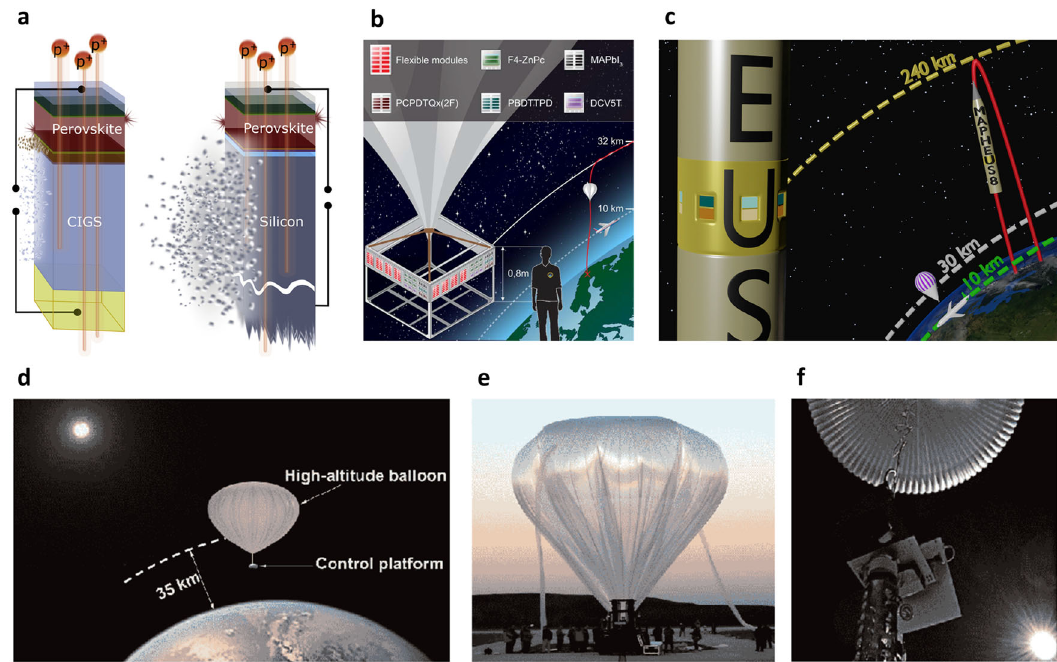
Fig. 8 Perovskite solar cells for space applications. a Device architecture for two different types of perovskite-based tandem solar cells. These two devices were tested against harsh radiation conditions (68 MeV high proton irradiation). a Adapted with permission from ref. 134 , Copyright 2020 Elsevier Inc. b Solar cell mounting structure, and schematics of the fl ight altitude. b Adapted with permission from ref. 136 , Copyright 2018 Elsevier. c Schematic Overview of the MAPHEUS-8 Sounding Rocket Flight. c Adapted with permission from ref. 137 , Copyright 2020 Elsevier Inc. d Representative schematic showing the relative position of the Sun, the high-altitude balloon, and the Earth (courtesy of National Aeronautics and Space Administration). e The photograph of launch site. f The photograph of the high-altitude balloon with a pod in near space. d – f adapted with permission from ref. 138 , Copyright 2019 Springer Nature.